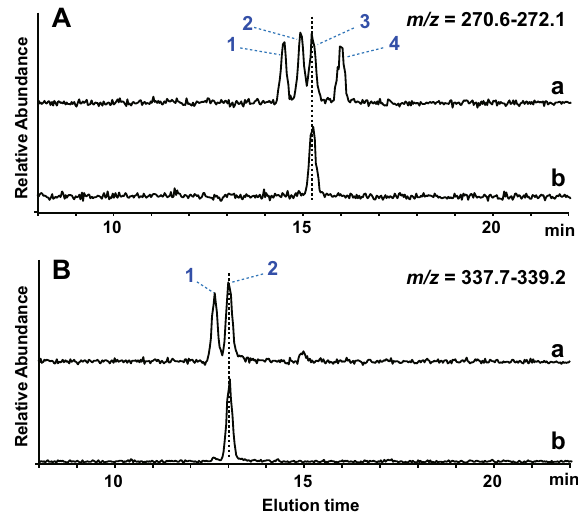
Figure 5. LC–MS analysis of the pentose monosaccharide released from the pentose-containing glycan. The pentose residue liberated from the pentose-containing N -glycan was labeled with 2AB or l-TrpNH 2 and then subjected to LC–MS. ( A ) Extracted ion chromatography (mass ranges m/z 270.6–272.1) of 2AB-labeled pentoses. (a) Chromatograph of the pentose monosaccharide mixture used as a standard. The blue numbers denote 2AB-ribose (1), 2AB-lyxose (2), 2AB-arabinose (3) and 2AB-xylose (4). The chromatogram of the pentose monosaccharide released from the pentose-containing N -glycan by partial acid hydrolysis is in (b). ( B ) Extracted ion chromatography (mass ranges m/z 337.7–339.2) of l-TrpNH 2 -arabinose. l-TrpNH 2 -derivatized l-arabinose (1) and d-arabinose (2) were utilized as standards (a). (b) Chromatograph of an l-TrpNH 2 - derivative of arabinose released from the original N -glycan by partial acid